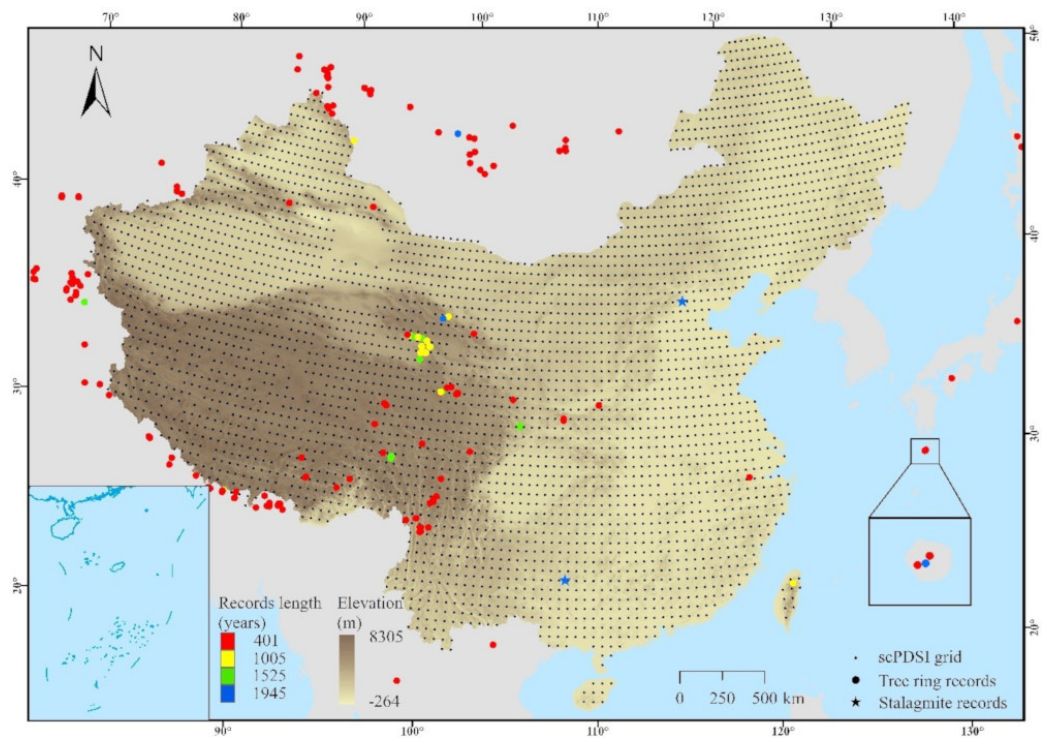
Figure 1. Geographical position and territory of China and the proxy records distribution map.